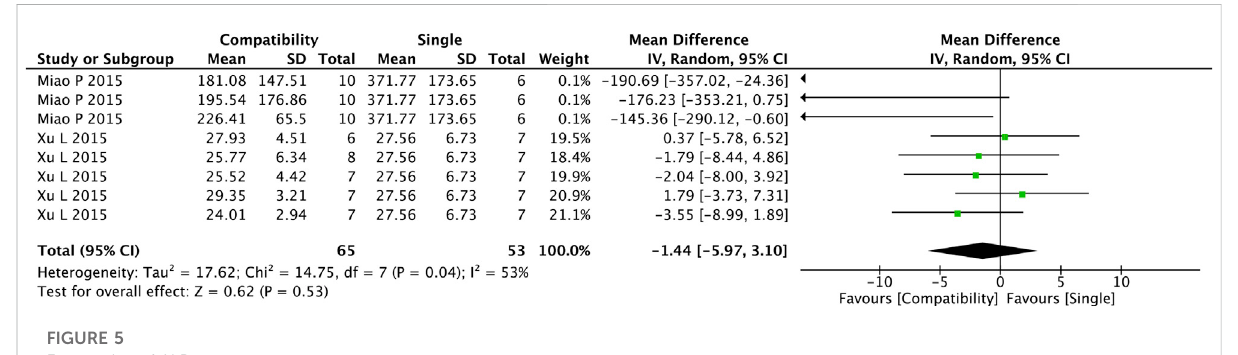
FIGURE 5 Forest plot of